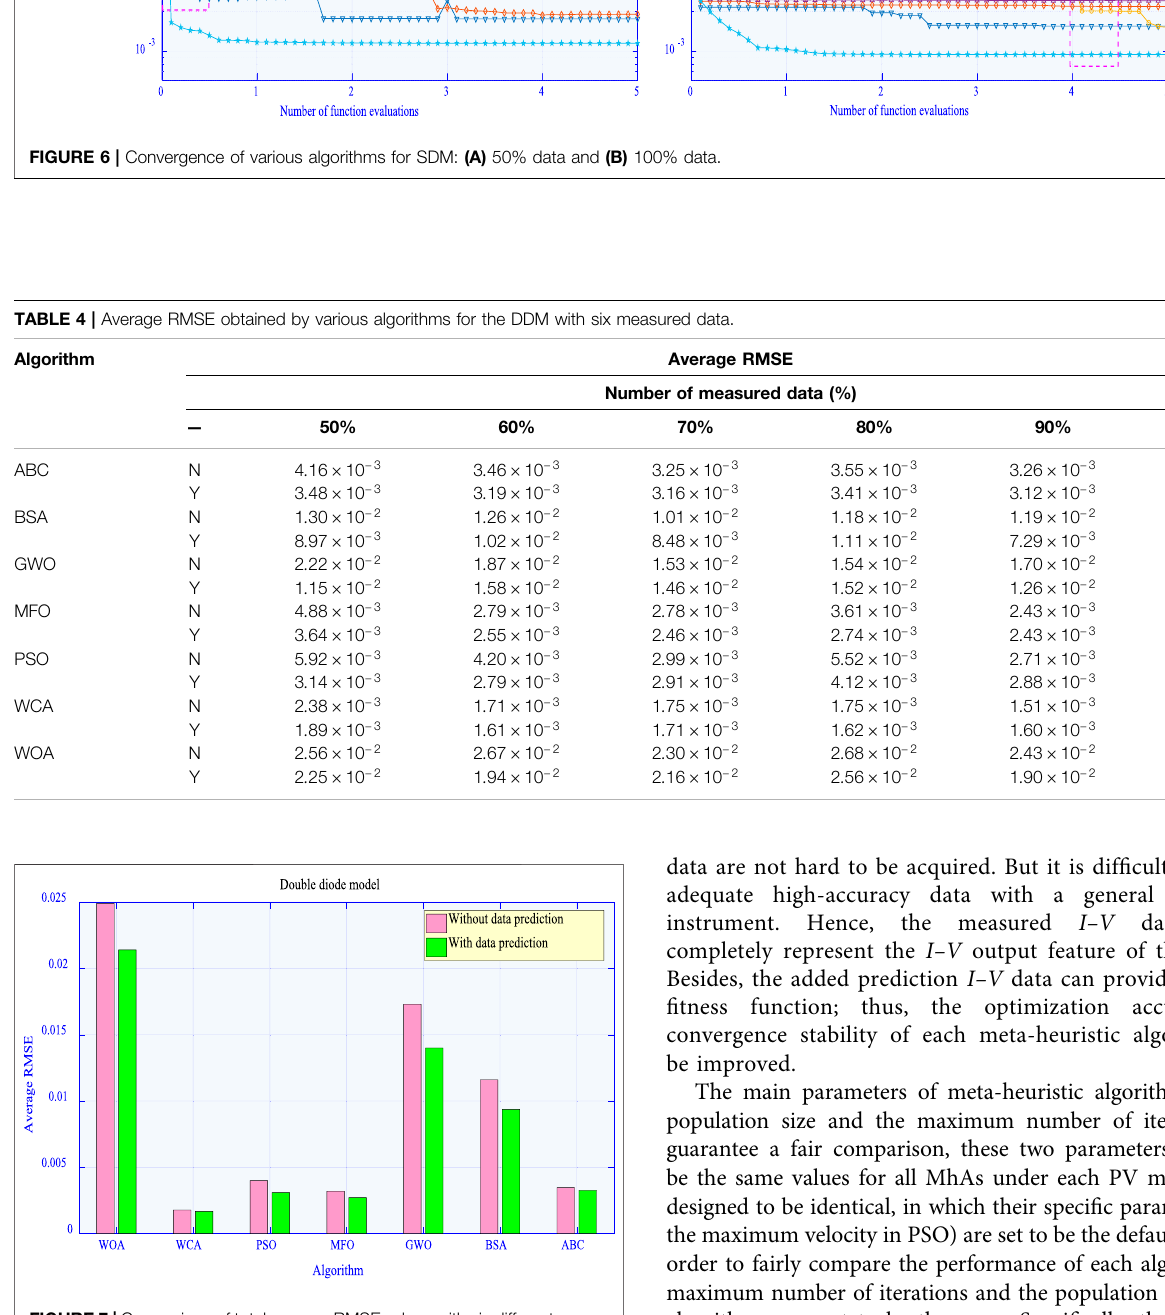
FIGURE 7 | Comparison of total average RMSE values with six different datasets for the